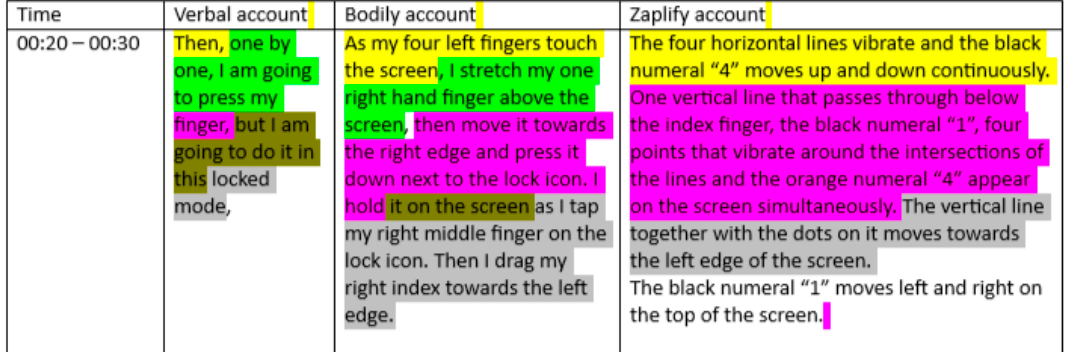
Figure 9. An excerpt from the transcription organized in a table.